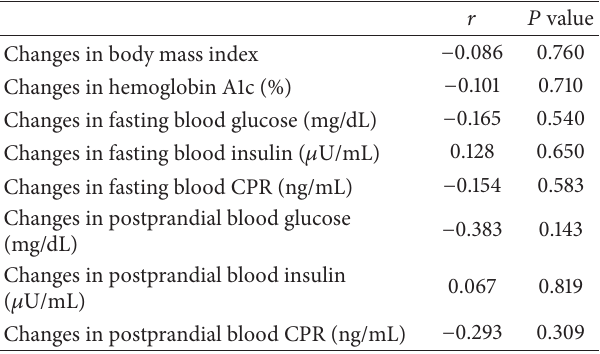
Table 4: Correlation between changes in glucose infusion rate at euglycemic-hyperinsulinemic clamp and clinical variables in patients treated with